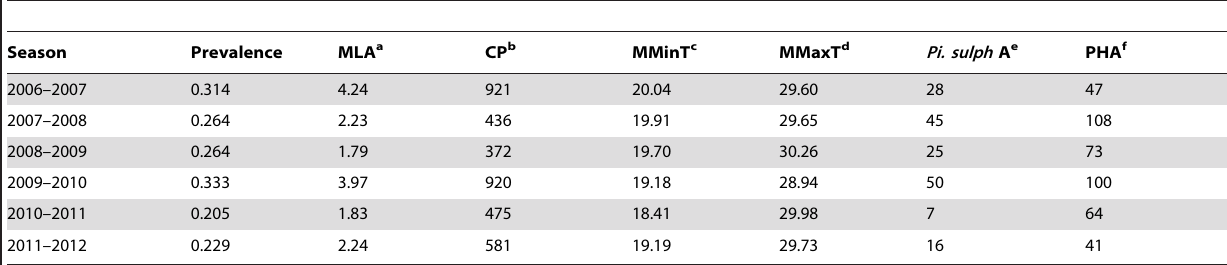
Table 1. Annual estimates of P. torquans parasitism, host abundance and climatic variables observed at one of the study sites (the reserve) from 2006 through 2012 during the first two thirds of each breeding